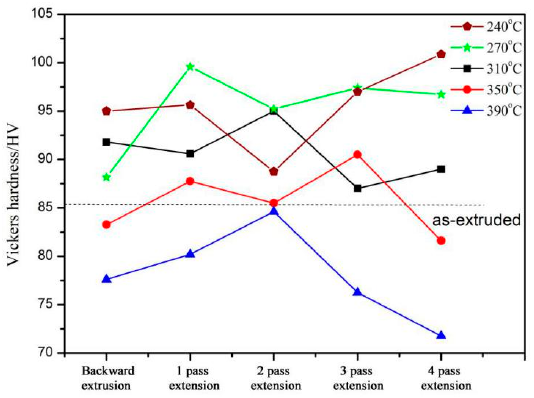
Figure 11. Vickers hardness of magnesium alloy tubes at different passes with different temperatures without annealing.